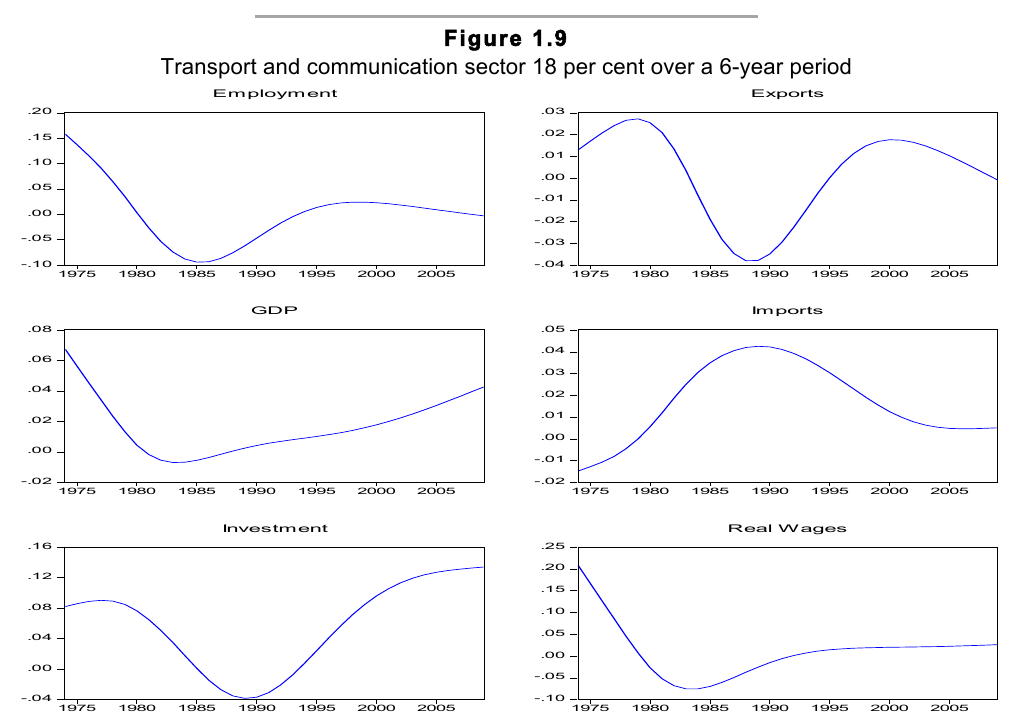
Transport and communication sector 18 per cent over a 6-year